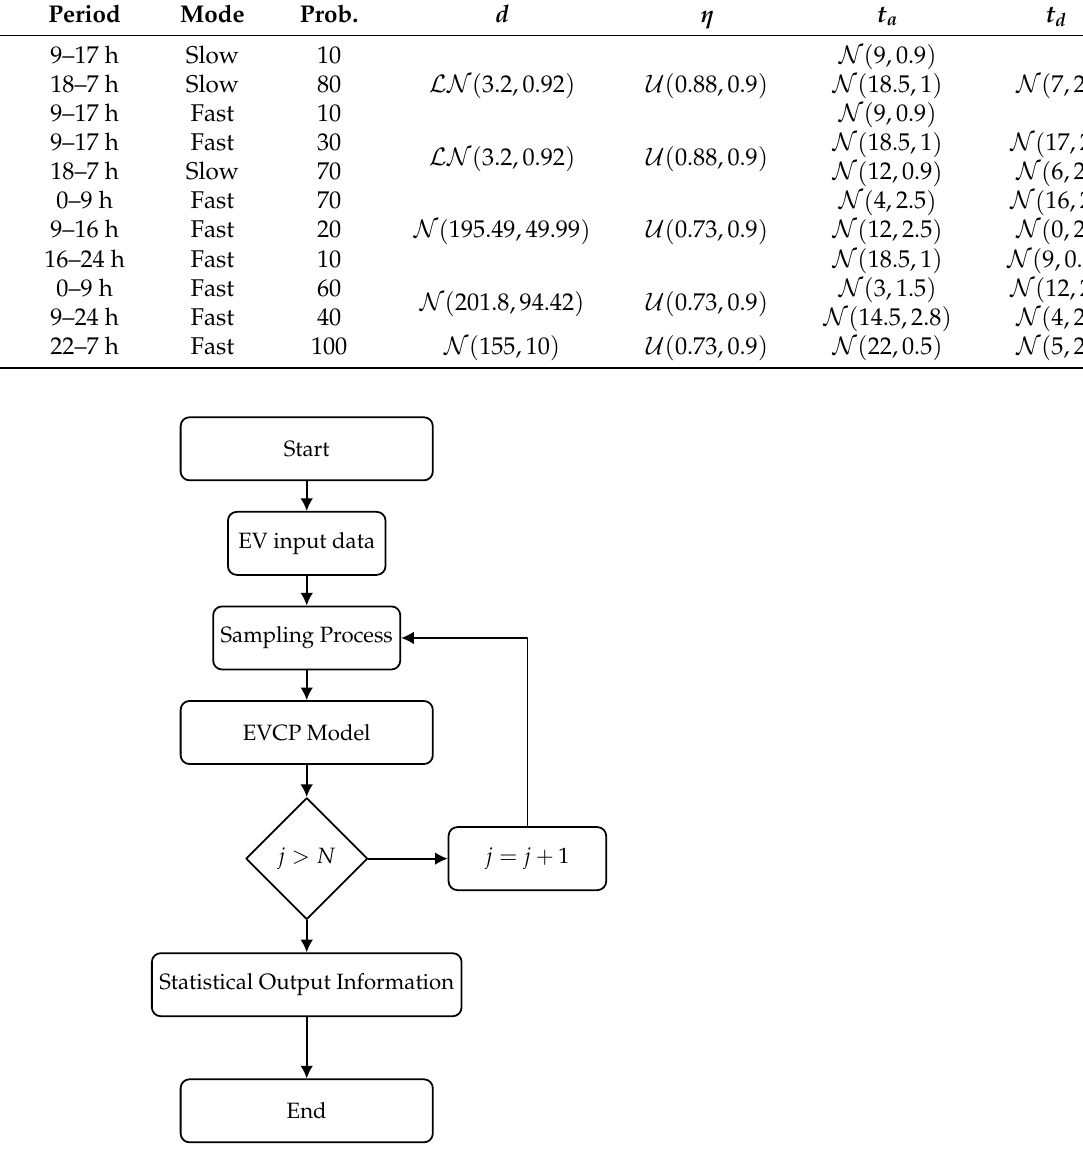
Figure 2. Flowchart for the EV charging probabilistic